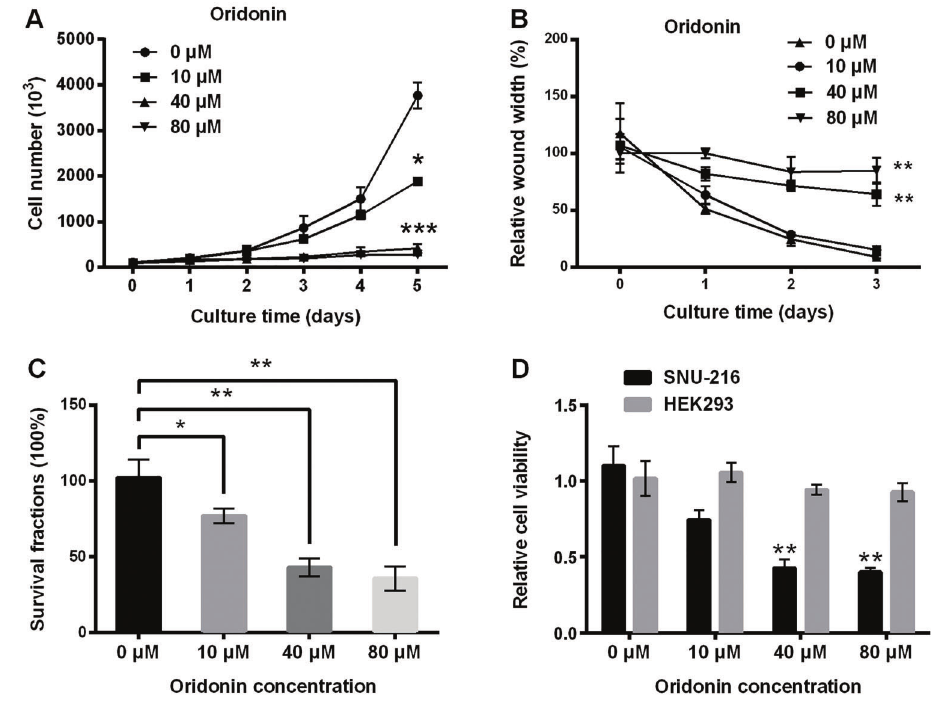
Figure 1. Oridonin inhibited the growth, migration, and survivability of SNU-216 cells. Cells were treated with a series of oridonin (0, 10, 40 and 80 m M) for indicated days. A , Viable cell number was measured by trypan blue dye staining. B , Cell migration was assessed by wound healing assay. After treatment with oridonin for 24 h, the survival fraction of cells was detected by clonogenic assay ( C ), and cell viability of SNU-216 cells and HEK293 cells was measured by CCK-8 assay ( D ). Data are reported as means ± SD. *P o 0.05, **P o 0.01, ***P o 0.001 compared to 0 m M